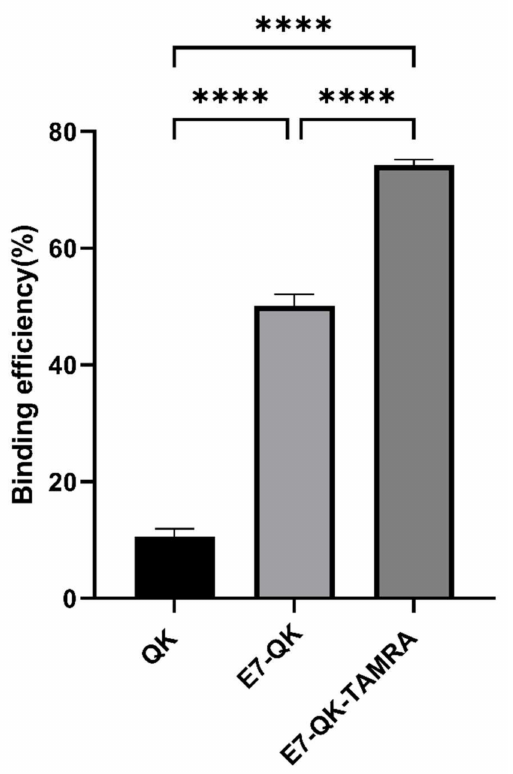
Figure 1. Binding efficiency of VEGF-mimicry peptides to HA particles. QK peptides (0.25 mM) with or without E7-tag and TAMRA-label were incubated with equilibrated HA particles for 2 h at RT. Biochemical measurements of peptide concentration were performed before and after incubation with HA particles. Binding efficiency (in percent) compared to the initially applied peptide concentration is illustrated in the diagram. **** p <